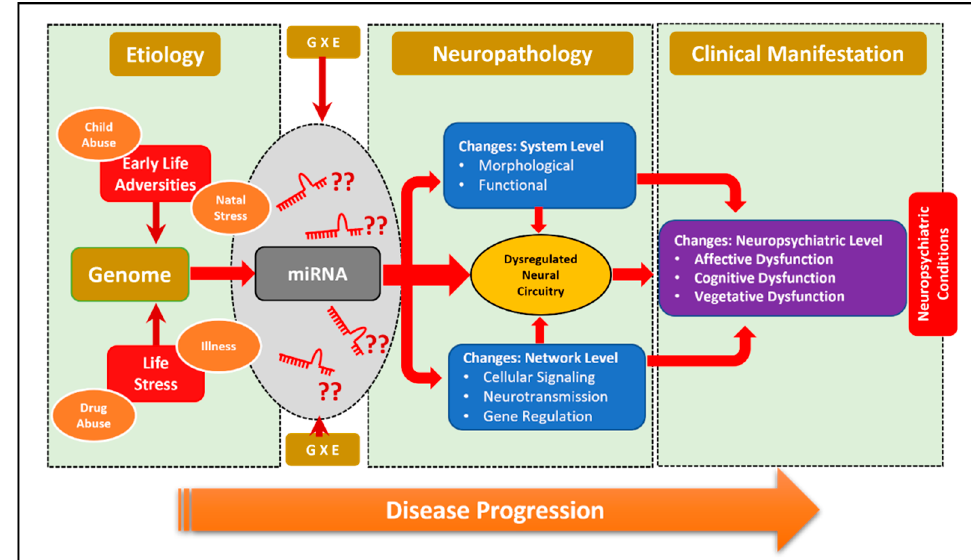
Figure 1. miRNAs as stress-induced epigenetic regulators of neuropsychiatric disorders. Gene and environmental (GXE) crosstalk shape the miRNA-based epigenetic landscape of the brain in neuropsychiatric disorders, largely triggered by various stress-inducing factors.